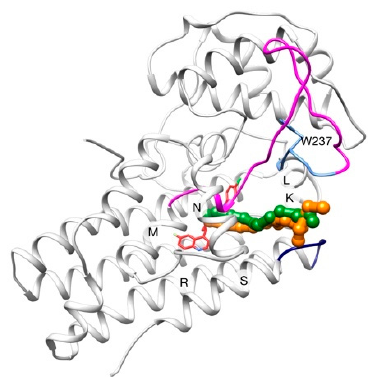
Figure 5. Pathways from GPathFinder calculations (colored in orange and green), where each point represents the BMS center of mass at this frame. LM-loop is colored in magenta, and its hairpin in blue (W237 in sticks). RS-loop is colored in dark blue and BMS in its binding pose is shown in red sticks.